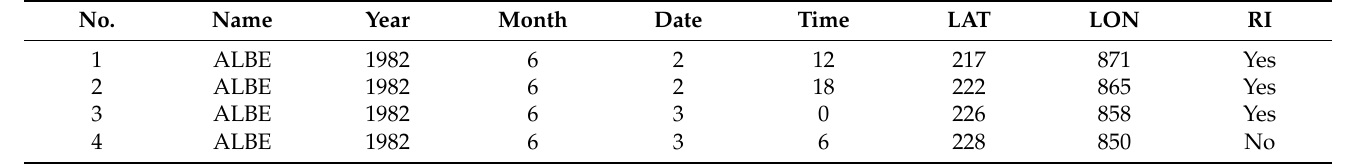
Table 2. Spatial, temporal, and intensity information of Hurricane ALBE which occurred in June